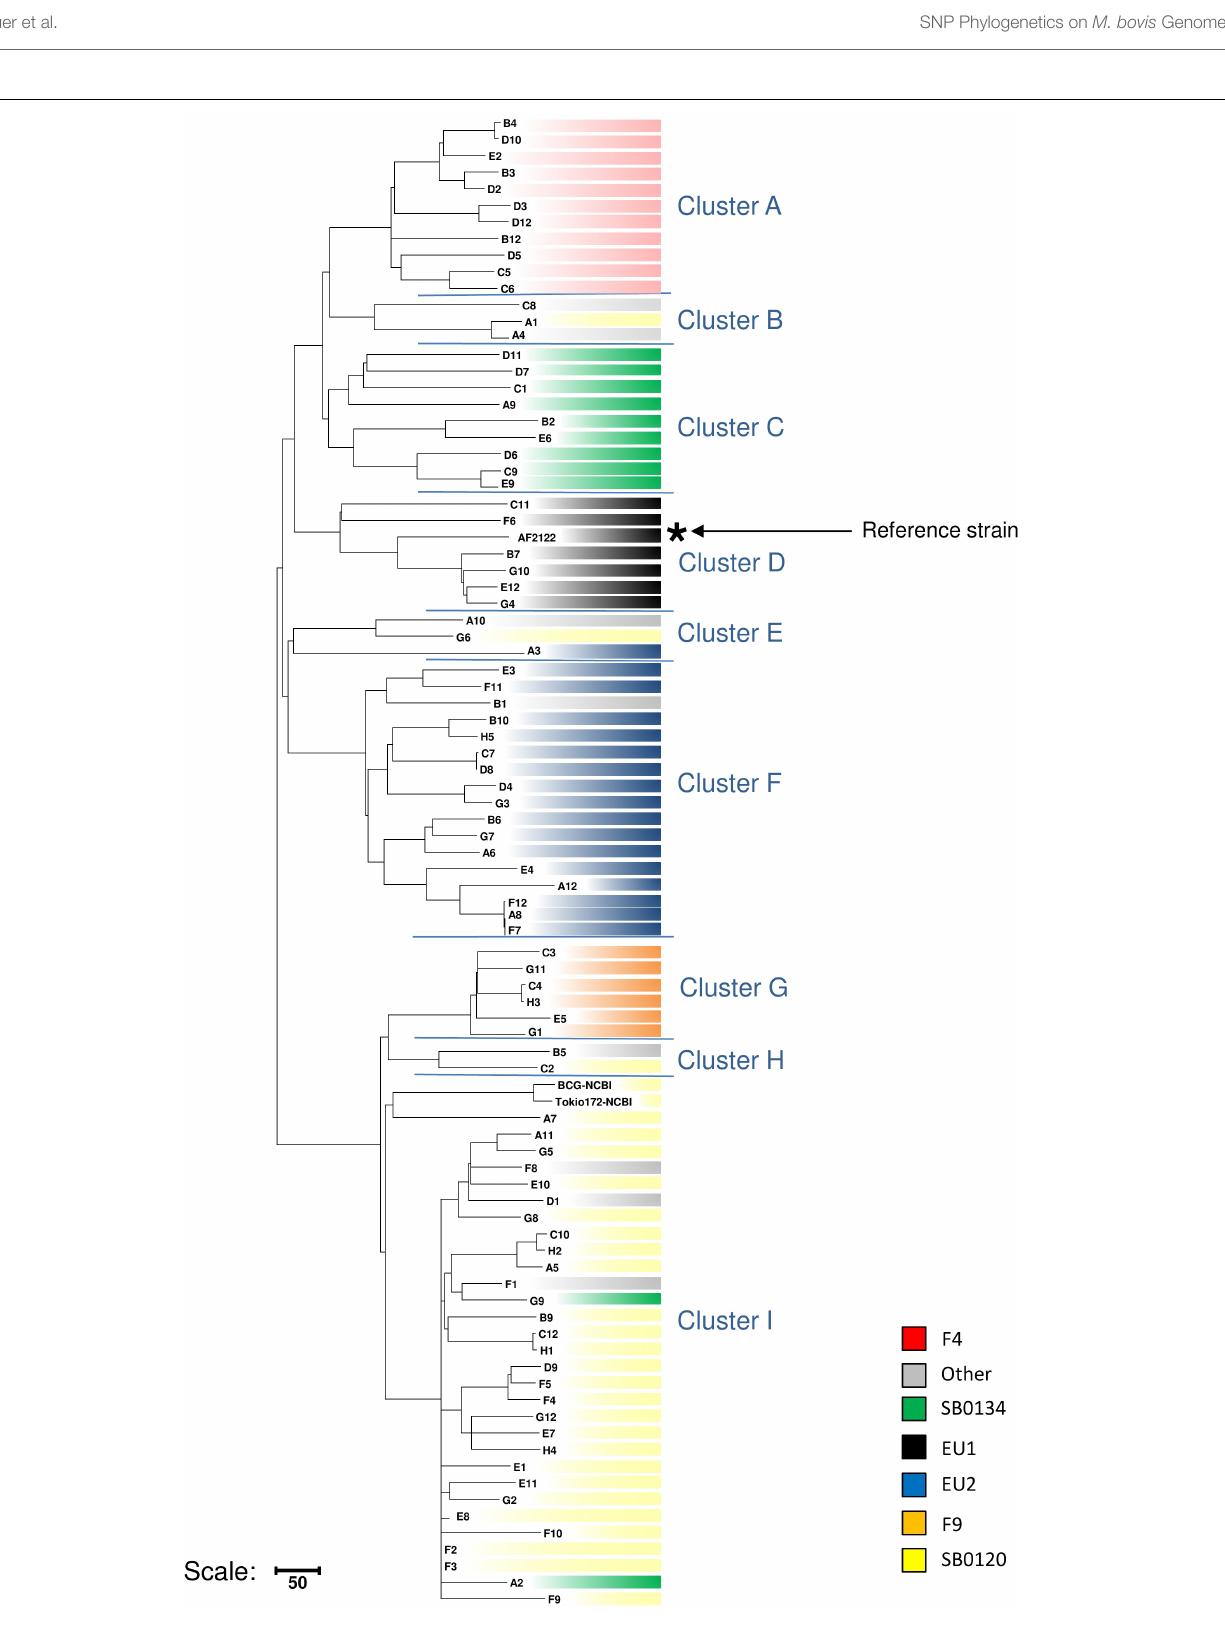
FIGURE 4 | Detail of number of SNPs discriminating the cluster of strains. Maximum parsimony tree based on the 9,170 SNPs identified through the mapping of 87 French M. bovis sequences on AF2122/97 reference sequence created using MEGA4 (Tamura et al., 2007). Numbers indicated on the branches represent the numbers of SNP. The tree is subdivided in nine main clusters described in the